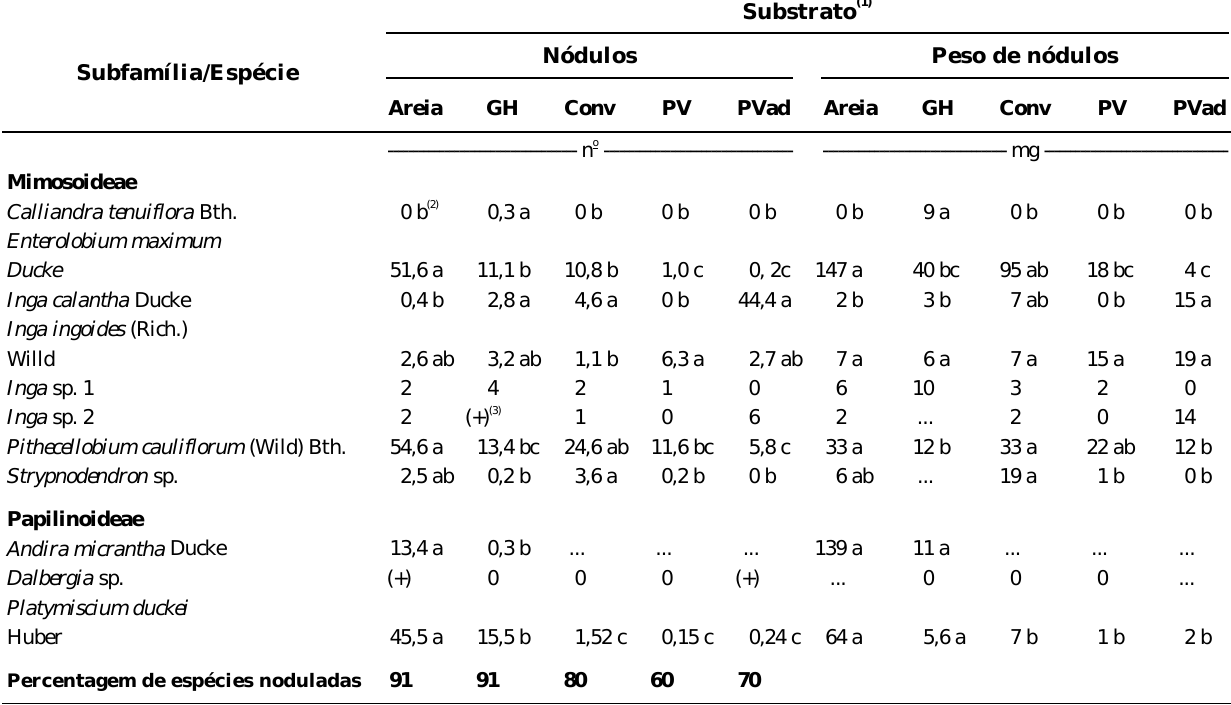
Quadro 7. Nodulação de espécies de leguminosas arbóreas, oriundas de terra firme da Amazônia, em cinco substratos no viveiro